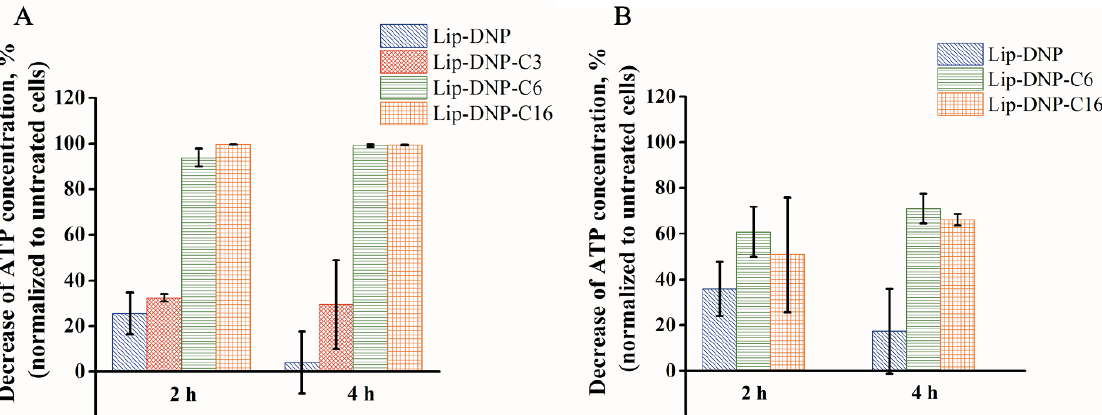
Figure 6. Decrease in ATP content in AML12 cells after treating with the 200 µM 2,4-DNP (compound 1 ), 2,4-DNP-C16 (compound 2 ), 2,4-DNP-C6 (compound 3 ), 2,4-DNP-C3 (compound 4 ) loaded into liposomes, composed of ( A ) eggPC/DSPE-PEG-OMe (95/5 molar ratio) and ( B ) DSPC/DSPE-PEG-OMe (95/5 molar ratio) lipids, for 2 h and 4 h, normalized to the ATP content in AML12 untreated cells. Data are presented as mean ± StD ( n = 3). The average cell concentration was 1 × 10 4 cell/mL.